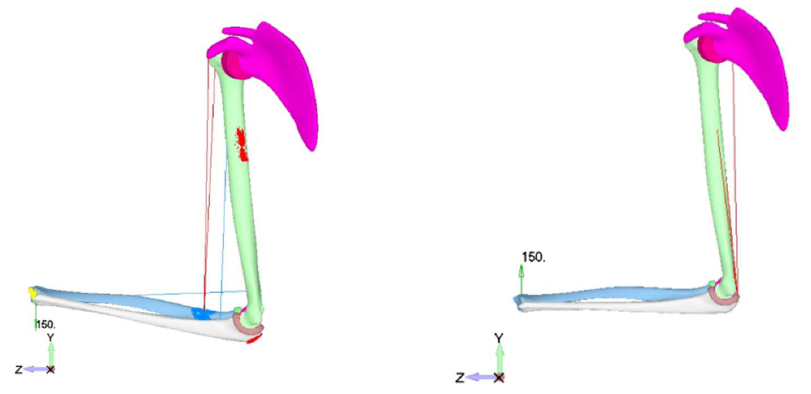
Figure 8. Applied load (150 N) in wrist, vertical direction, biceps analysis ( left ) and triceps analysis